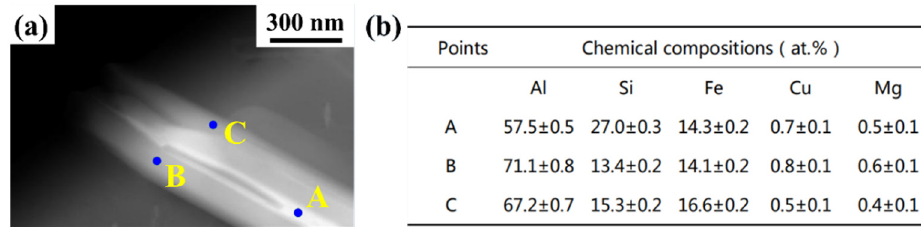
Figure 5. Transmission electron microscopy bright field image ( a ) showing Al-Fe-Si intermetallic phase in the SLM fabricated Al-20Si-5Fe-3Cu-1Mg sample with substrate plate heating and ( b ) table showing the EDS analysis data observed for the points marked in ( a ).